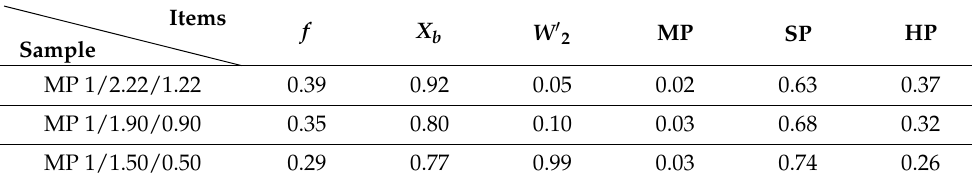
Table 4. Calculated terms related to microphase separation in the bio-based SMTPUs.